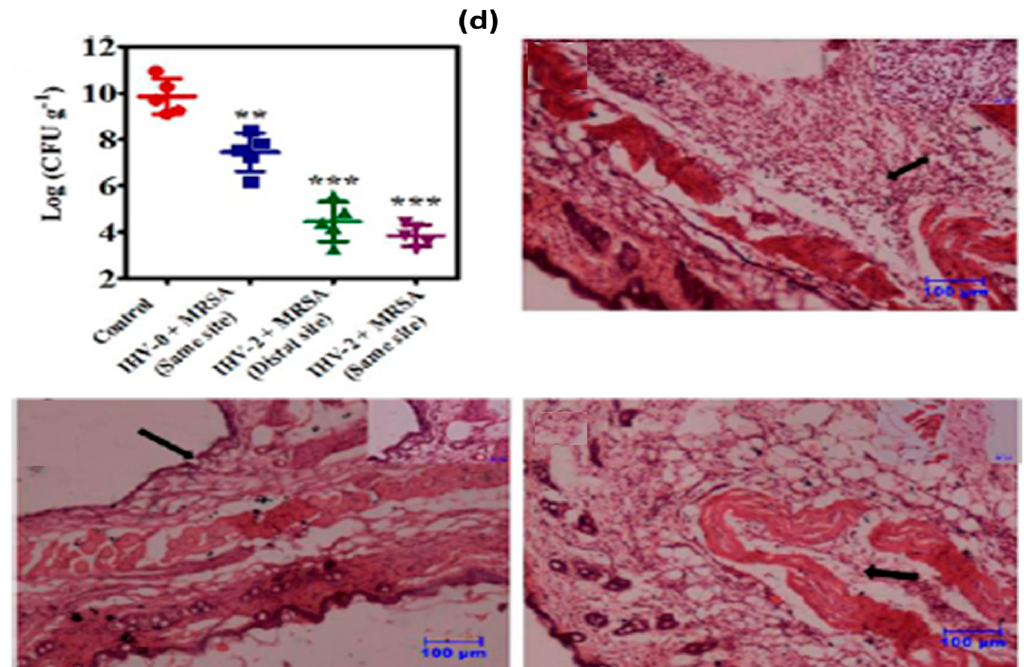
Figure 18. Schematic representation of the antibiotic loaded hydrogels ( a ); antibacterial activity of the hydrogels. Bacterial count after 6 h when 150 μ L of the pathogen ( b ); antibiotic release from the vancomycin-containing hydrogels ( c ); in vivo activity of the hydrogels. Evaluation of antibacterial activity upon injection of MRSA subcutaneously in mice ( d ) (*, ** and *** denotes to significant error) (adapted with permission from Hoque et al., 2018).